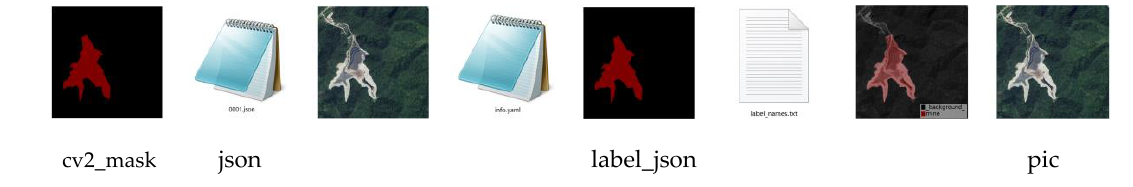
Figure 7. Dataset folder of training data.